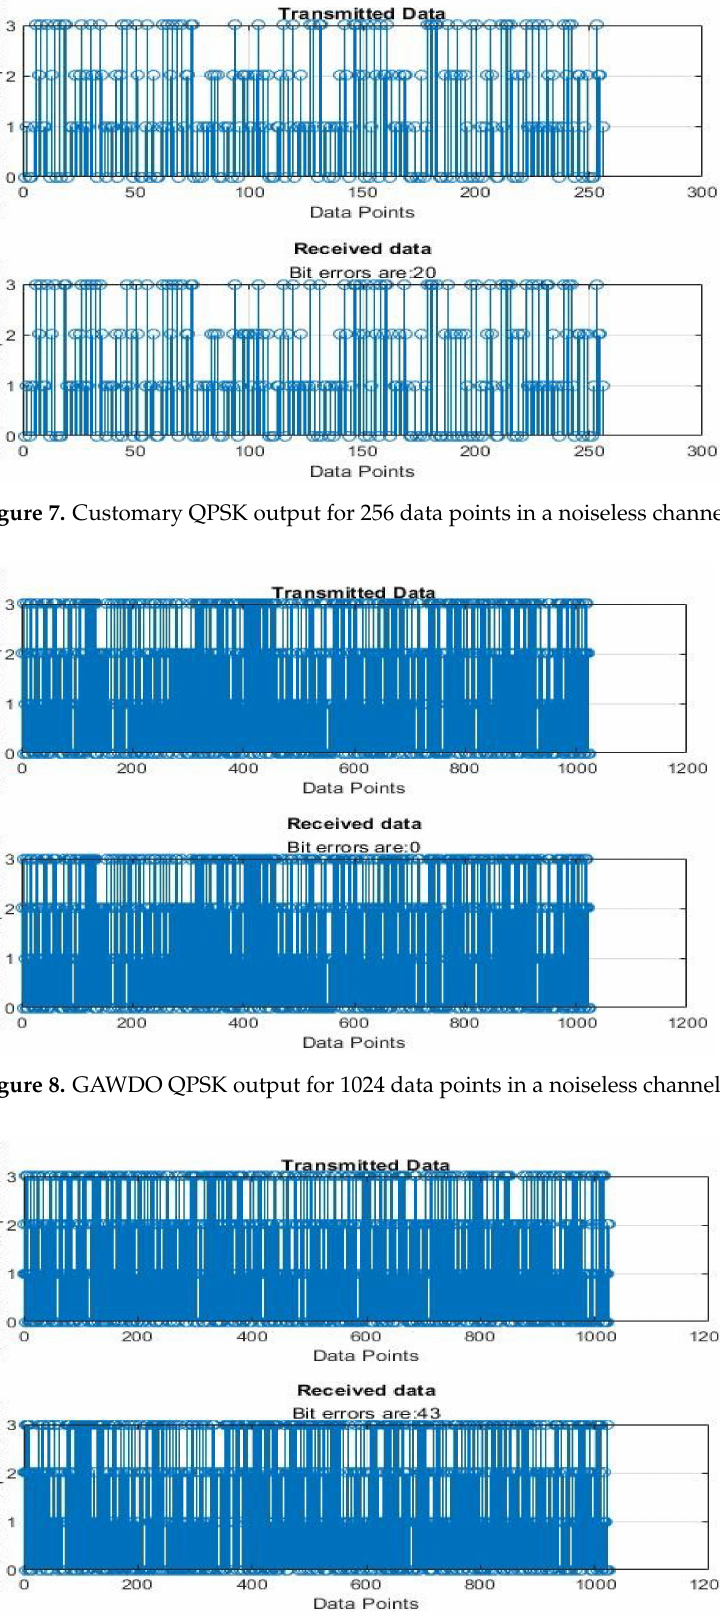
Figure 9. Customary QPSK output for 1024 data points in a noiseless